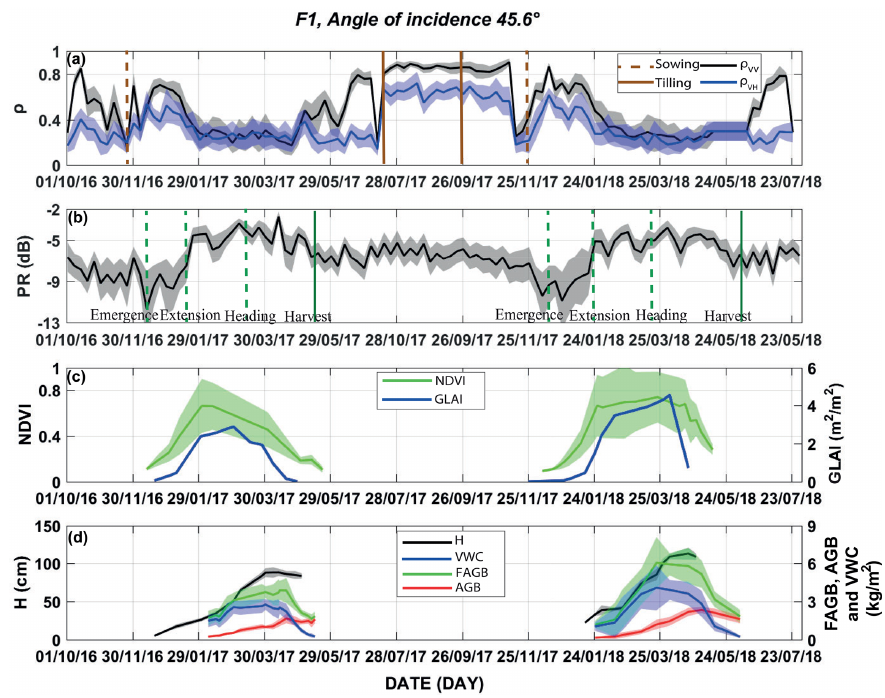
Figure A7. Time series of the interferometric coherence at VV and VH polarizations (a) and the polarization ratio (b) on F1 at a 45.6 ◦ incidence angle during the period from 1 October 2016 to 31 July 2018. The tilling works and phenological stages of wheat are superimposed in panels (a) and (b) , respectively. The NDVI and measured GLAI are displayed in panel (c) . Measured H , FAGB, VWC and AGB are plotted in panel (d) . Time series are presented by mean values (solid lines) and standard deviations (shading surrounding the solid lines).